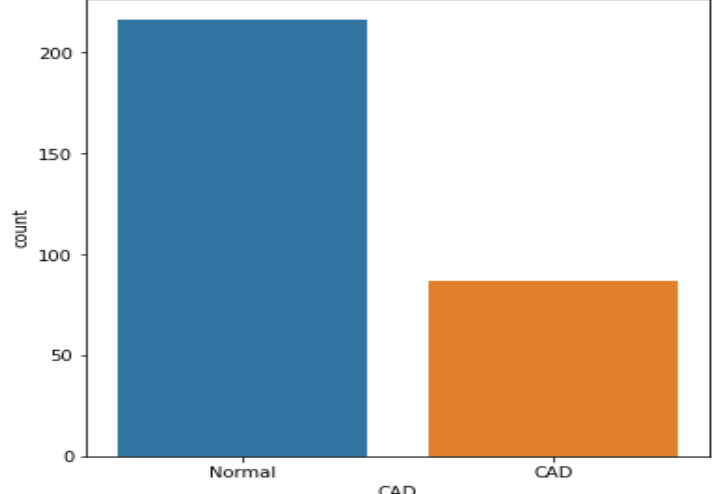
Figure 2. Sample distribution of the Z-Alizadeh Sani dataset.